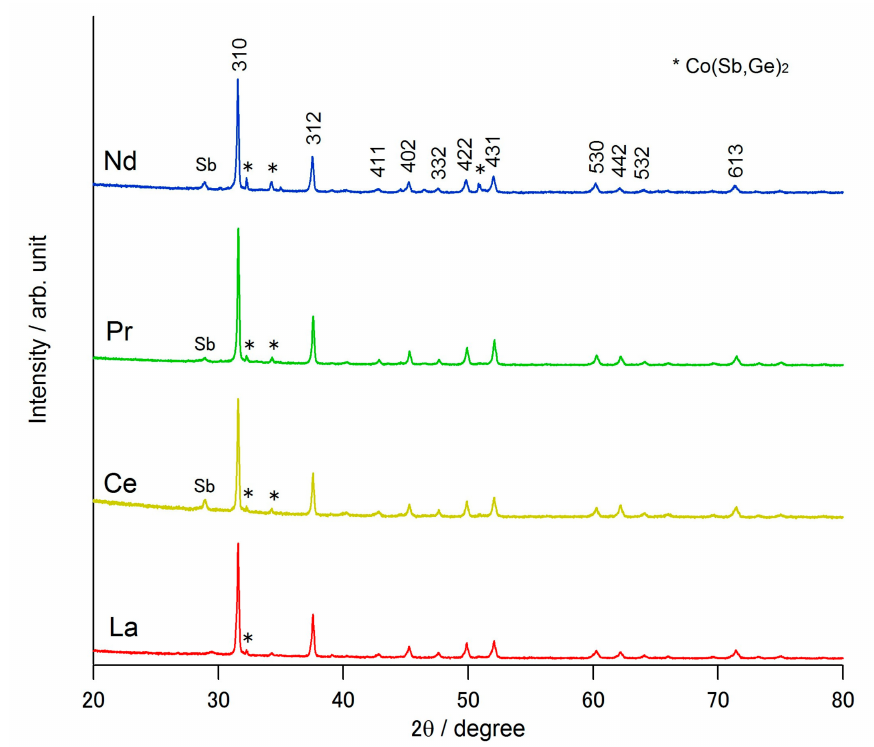
Figure 1. Powder XRD patterns of La, Ce, Pr, and Nd samples. The main phase is a Ge-substituted antimony skutterudite compound for each sample. Small diffraction peaks of Sb-Ge solid solutions and monoclinic Co(Sb,Ge) 2 are